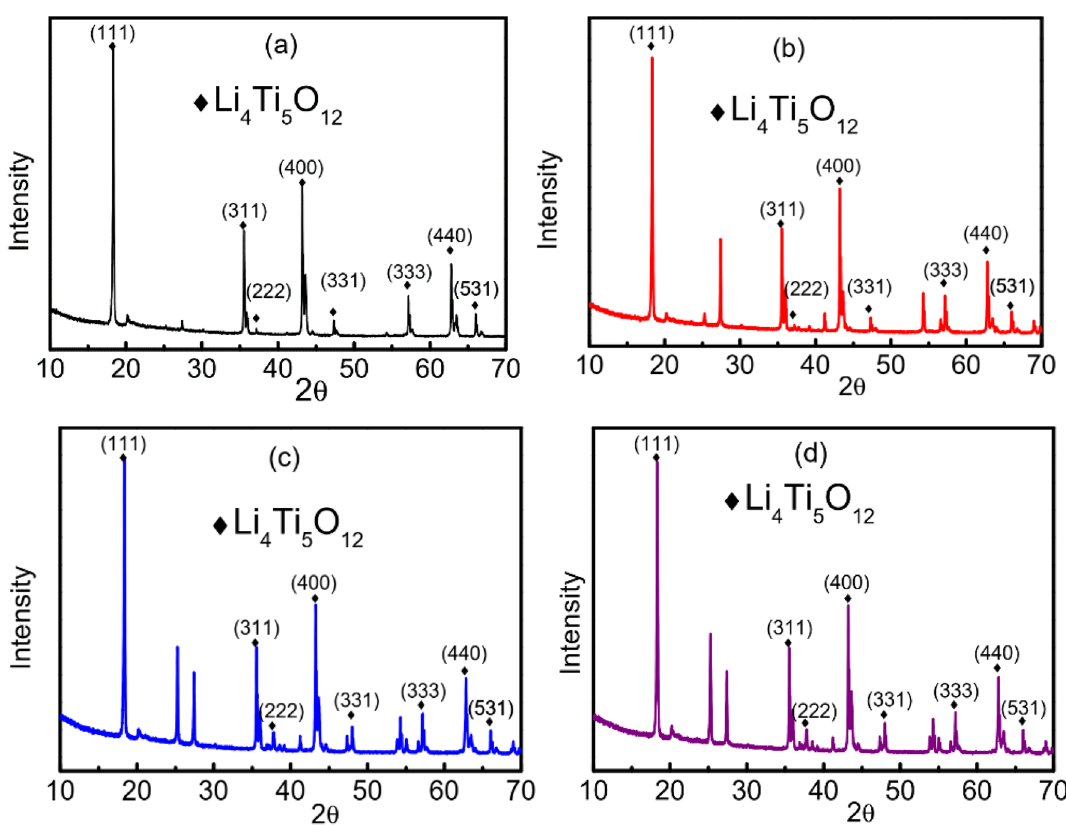
Fig. 2 XRD spectrum of the prepared LTO material of a GC1 b GC2 c GC3 d GC4